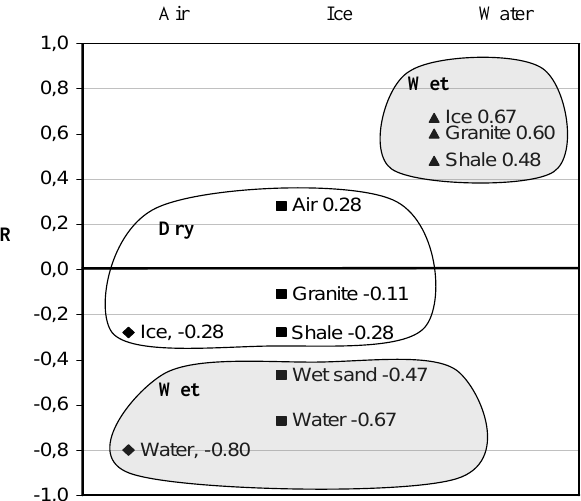
Fig. 2. Examples of reflection coefficients ( R ) for various inter- faces found in a glacial environment. The top caption is the mate- rial above the interface; the data labels state the material below the interface and the reflection coefficient. It is clear that the presence of water is connected to a strong reflection. Values from Davis and Annan (1989) and Murray et al.